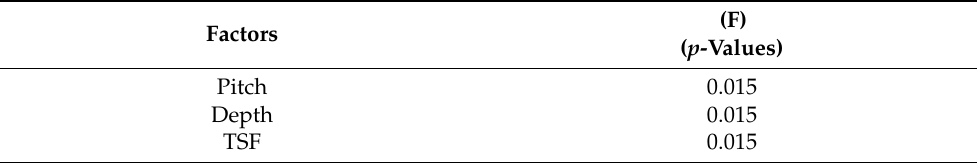
Table 6. Results of the variance analysis for the TSF shape factor, depth, and pitch.